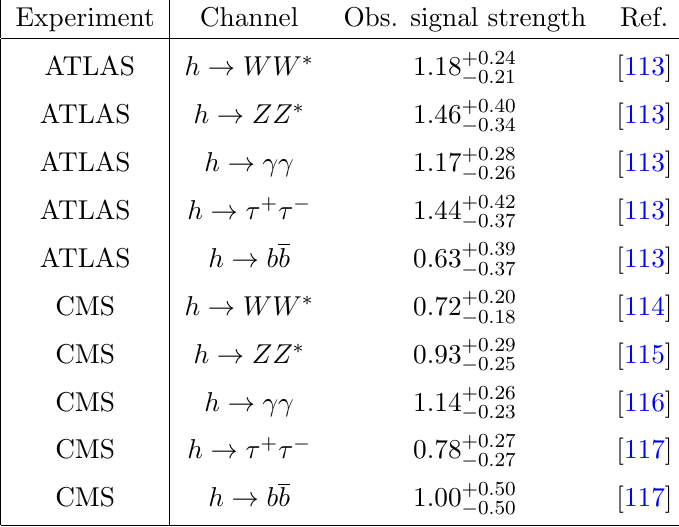
Table 2 . A summary of Higgs boson signal strength measurements that are included in our analysis. For more details, see Expt tables/latestresults-1.4.0-LHCinclusive/ directory of HiggsSignals v1.4.0